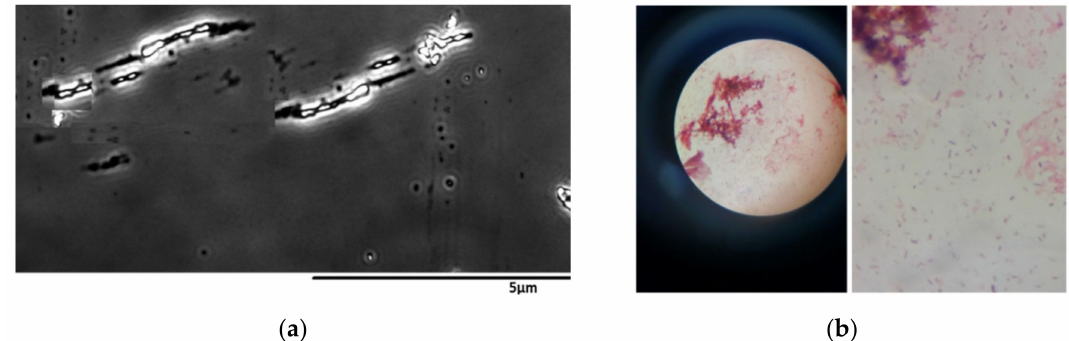
Figure 3. ( a ) Bacillus bacteria cell under SEM. Reproduced with permission from [30]. Copyright 2016, Elsevier. ( b ) Isolation of bacteria colonies under a stereo microscope. Reproduced with permission from [38]. Copyright 2019,